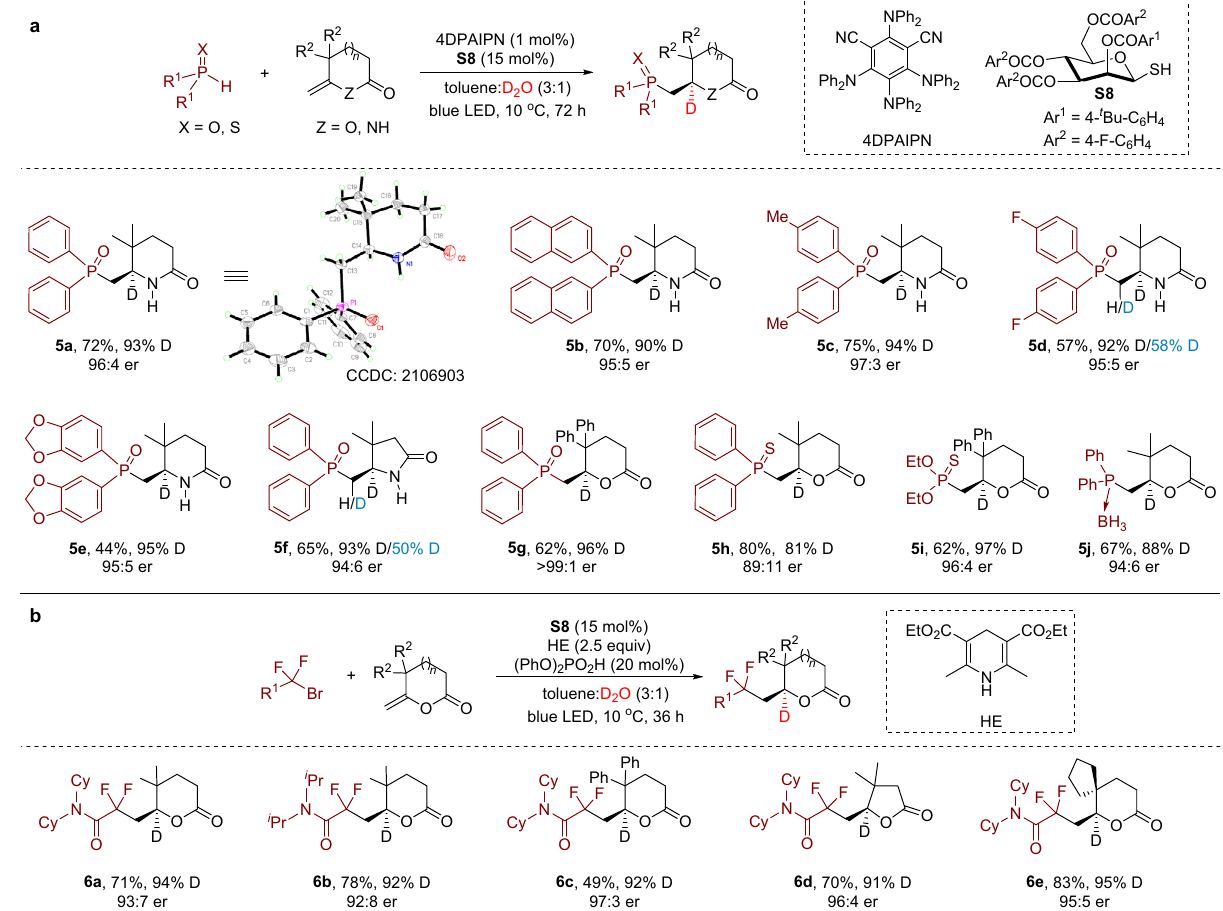
Fig. 3 | Sugar-derived thiol-catalyzed enantioselective deuterofunctionaliza- tion of exocyclic ole fi ns. a Enantioselective deuterophosphinoylation.